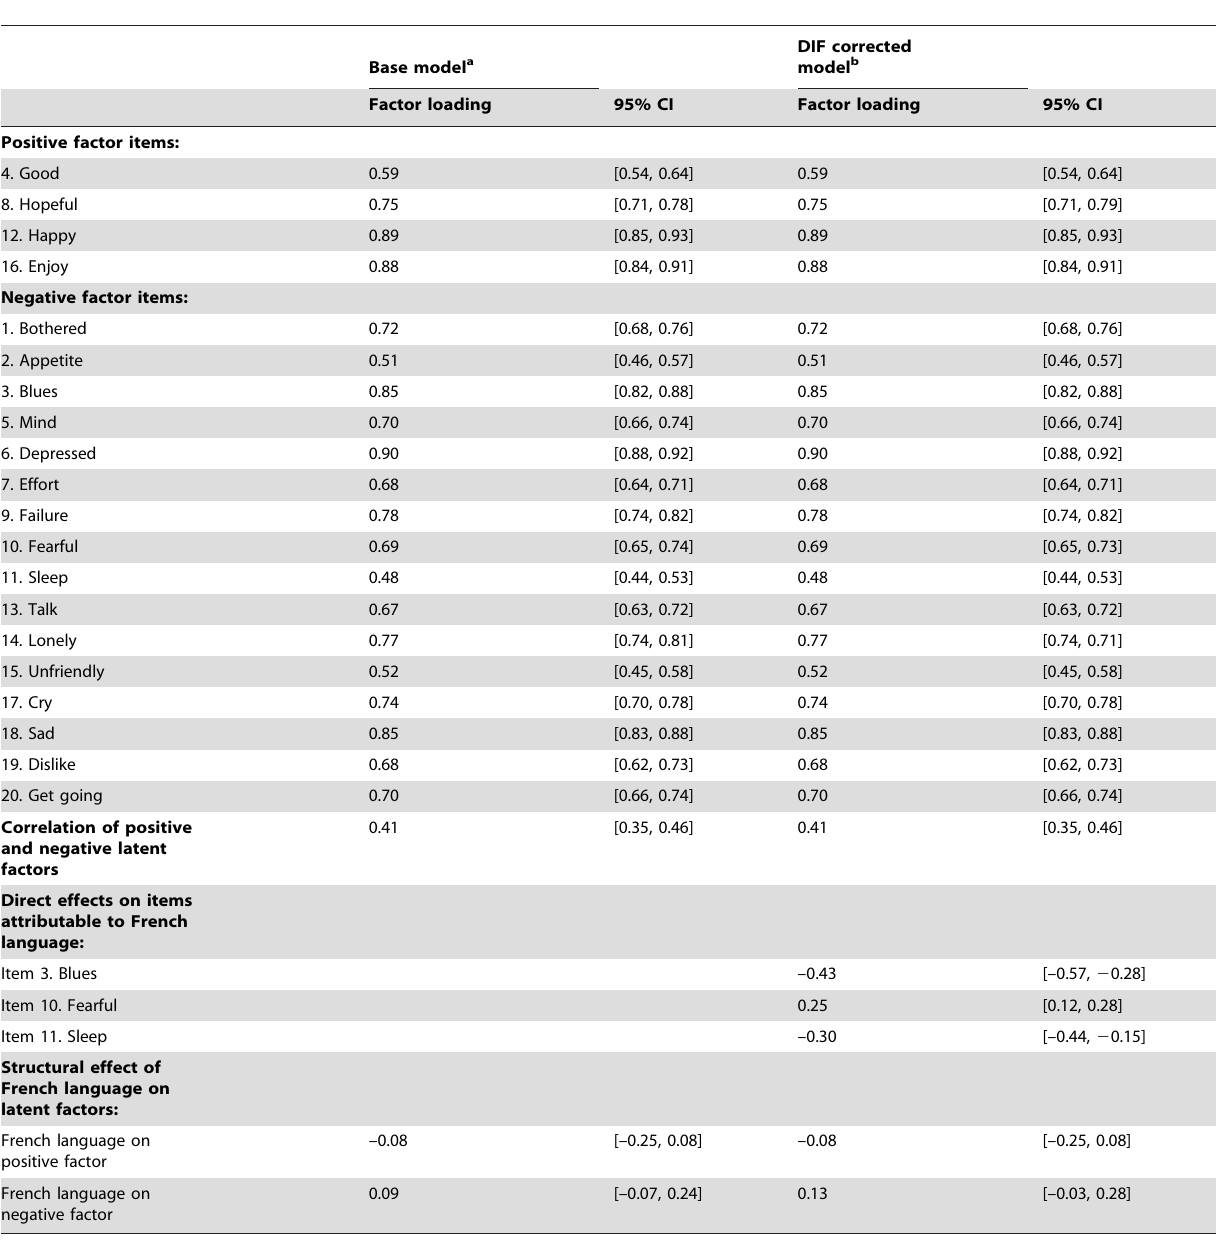
Table 2. Factor loadings for the ‘‘Positive’’ and ‘‘Negative’’ latent factors of the CES-D and influence on the overall estimates of fatigue latent factor